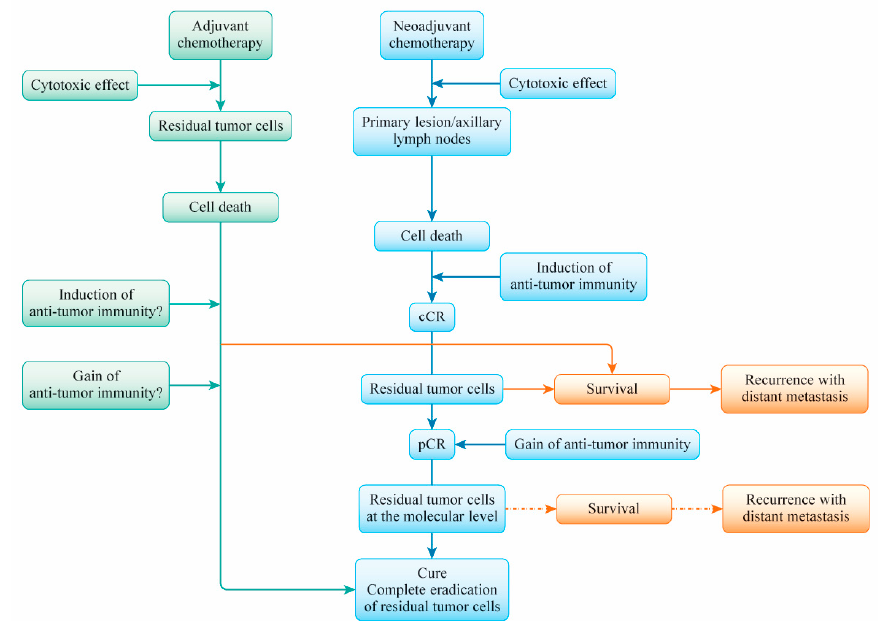
Figure 2. A scheme for the understanding of residual tumor cells’ causing of distant recurrence after neoadjuvant chemotherapy (NAC) or adjuvant chemotherapy in patients with breast cancer. When a patient responds to NAC, the anticancer